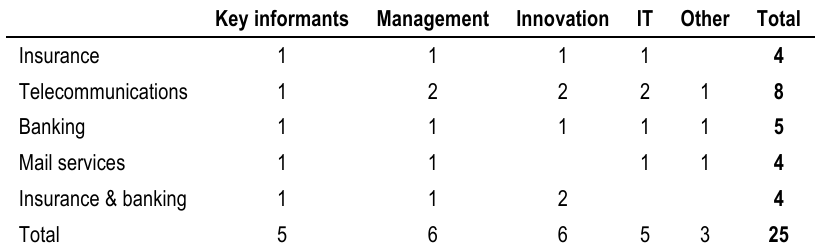
Table 2. Data sources